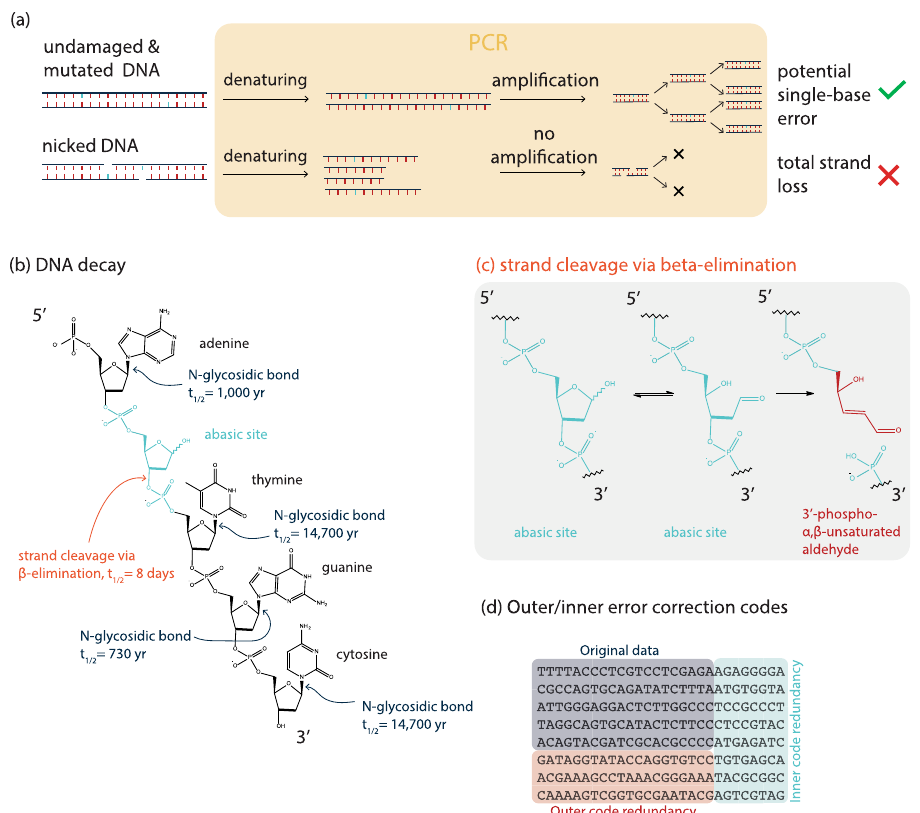
Fig. 1 Decay pathways during DNA data storage. a Denaturation of undamaged/mutated DNA and nicked DNA results in potential single-base loss and total strand loss, respectively. b Hydrolysis can lead to the release of bases with rates as indicated. Once an abasic site exists, strand cleavage proceeds via β -elimination 3 . c Mechanism of β -elimination resulting in a 3 ’ -phospho- α , β -unsaturated aldehyde 33 . d Structure of a DNA storage project with outer and inner code 15, 18, 19 .